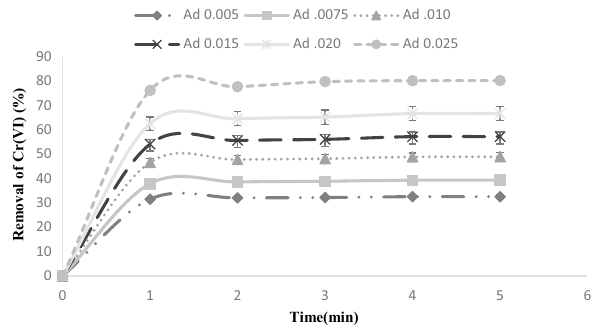
Fig. 8 Variation of percentage removal with time at different adsor- bent doses